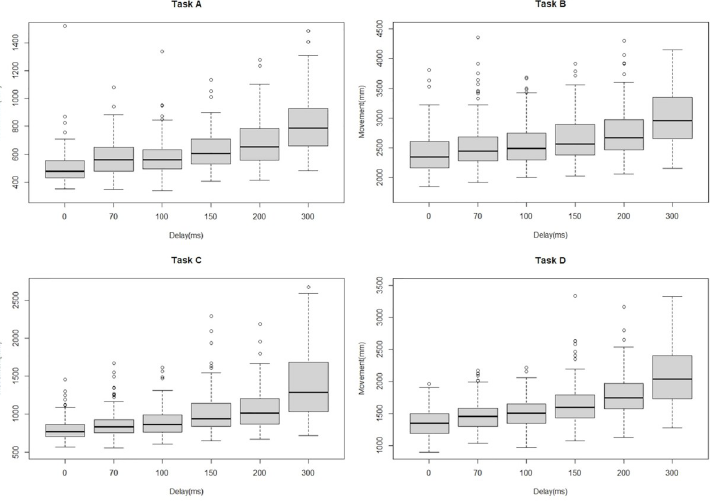
Fig 5. Boxplot of movement distance of forceps of each task by all